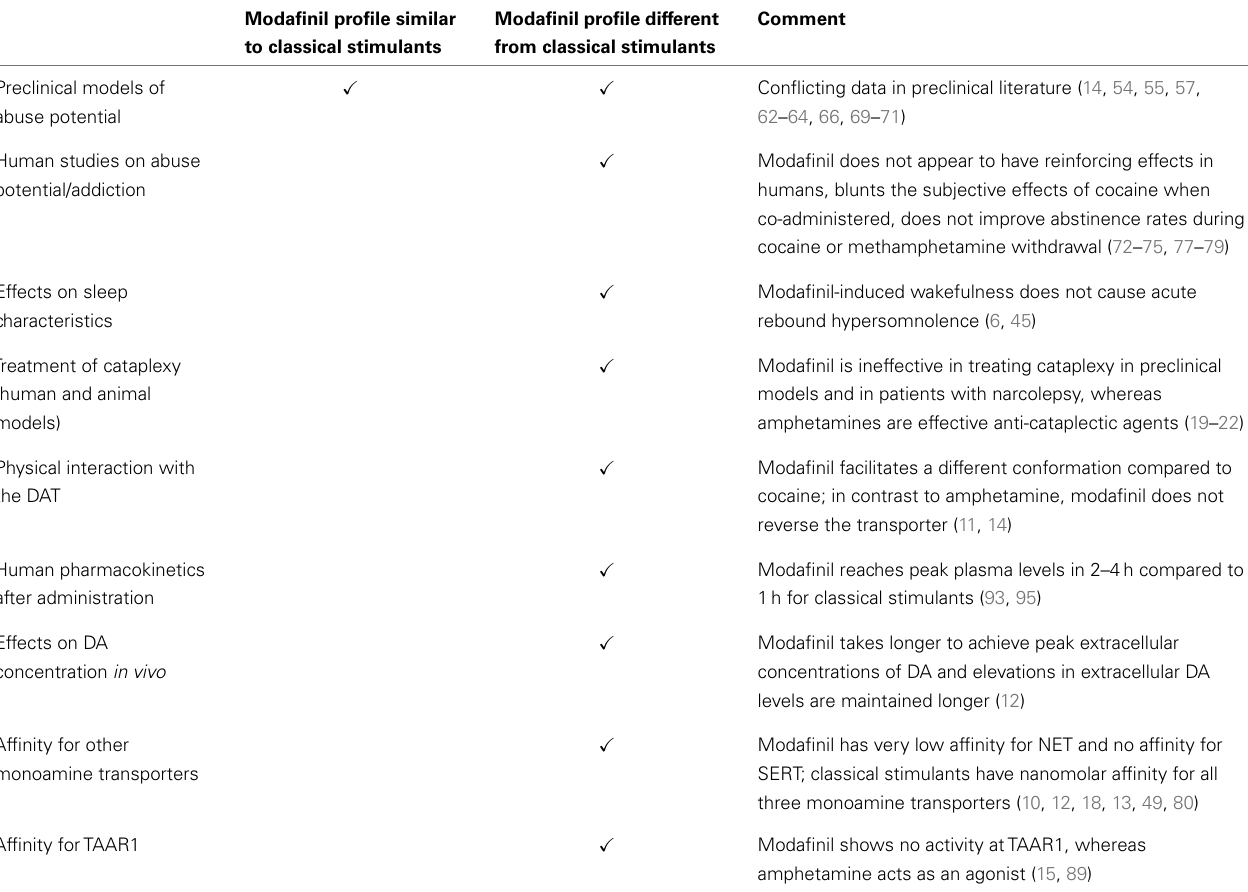
Table 2 | Effects of modafinil compared to classical